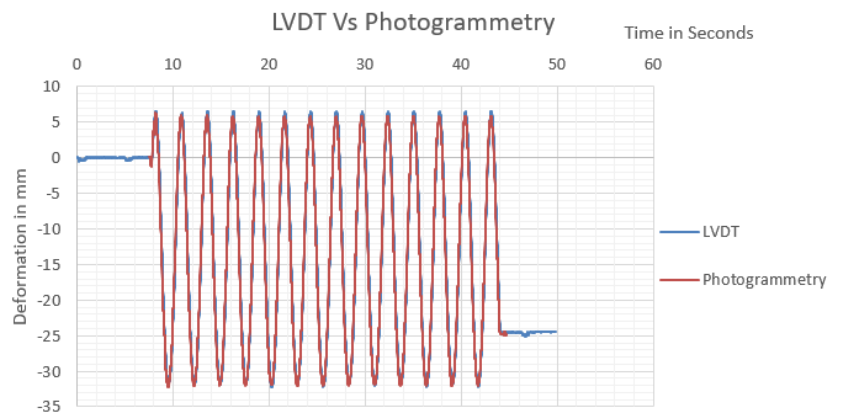
Figure 9. Linear variable differential transformer (LVDT) measured oscillation results vs. photogrammetry monitoring using a Harris corner detector.